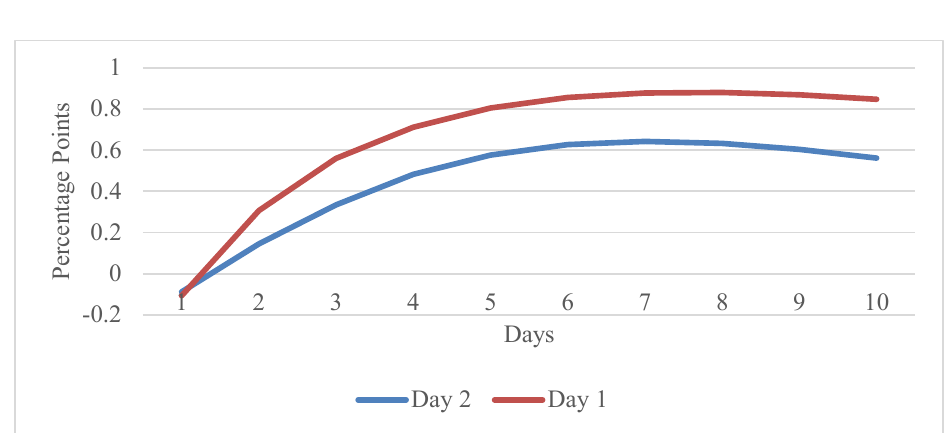
Fig. 7. Responses of unemployment rate to shocks at the beginning of the week.